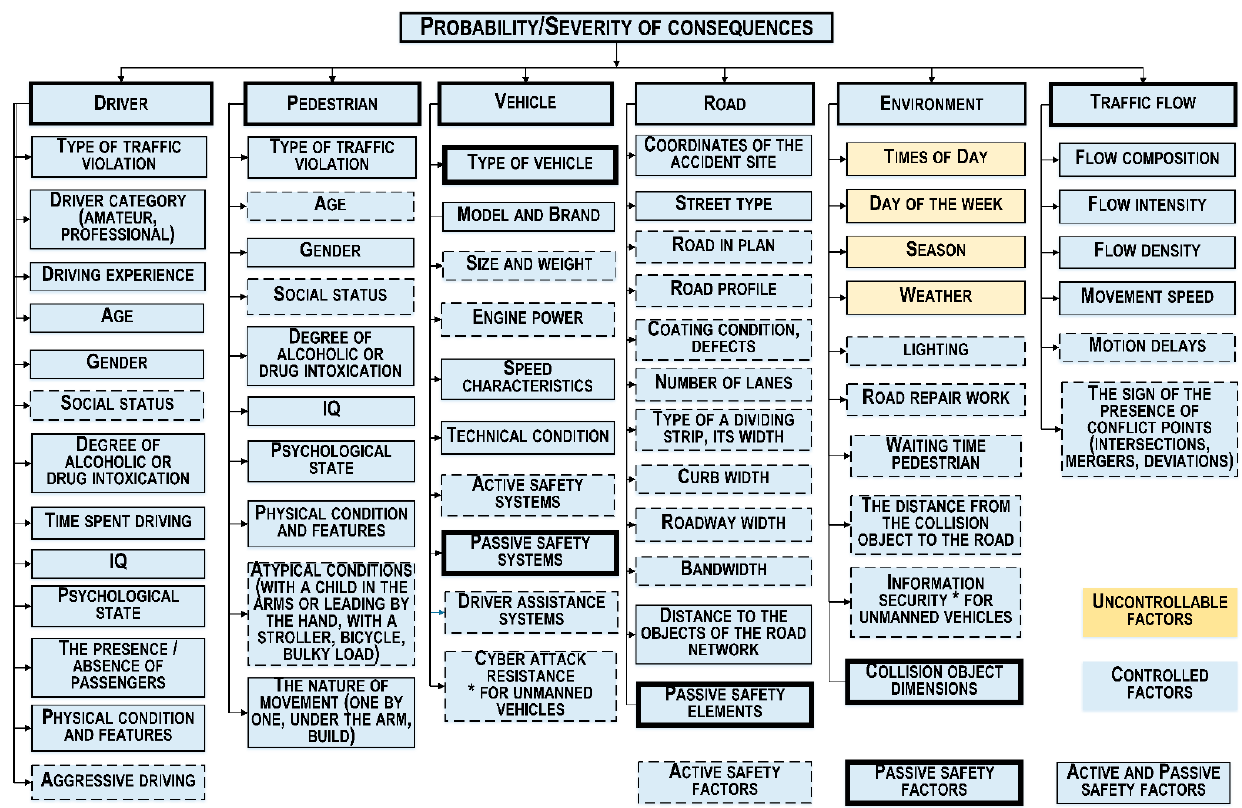
Figure 3. Emergency situation factor tree. (the factors with “ * for unmanned vehicles” apply only to unmanned vehicles).